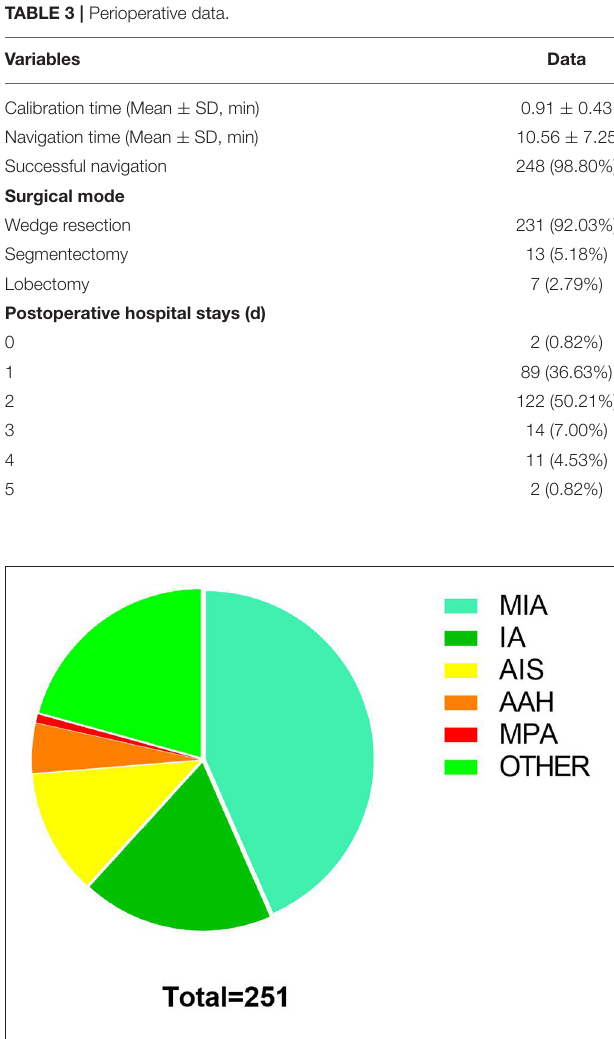
FIGURE 3 | Pathological results of nodules: minimally invasive adenocarcinoma (MIA,109,43.43%), invasive adenocarcinoma (IA,46,18.32%), adenocarcinoma in situ (AIS,30,11.95%), atypical adenomatous hyperplasia (AAH,12,4.78%), mucin-producing adenocarcinoma (MPA, 2, 0.80%), other including metastatic tumor, pulmonary hamartoma, aspergillus nodules, tuberculoma, fibrous nodule, granuloma, et al.